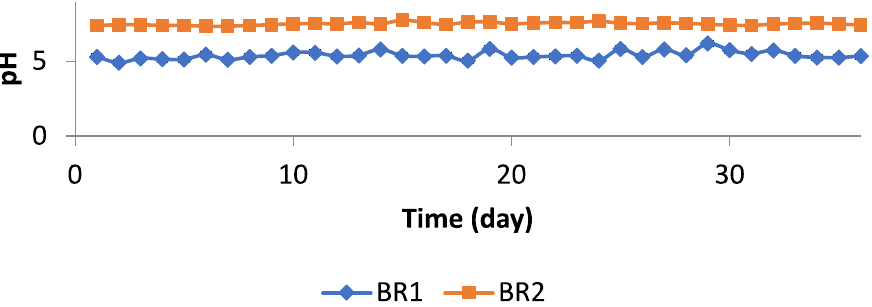
Figure 10. The profile of pH values for the biohydrogen (BR1) and biomethane (BR2) bioreactors during the continuous mode of TPAD of